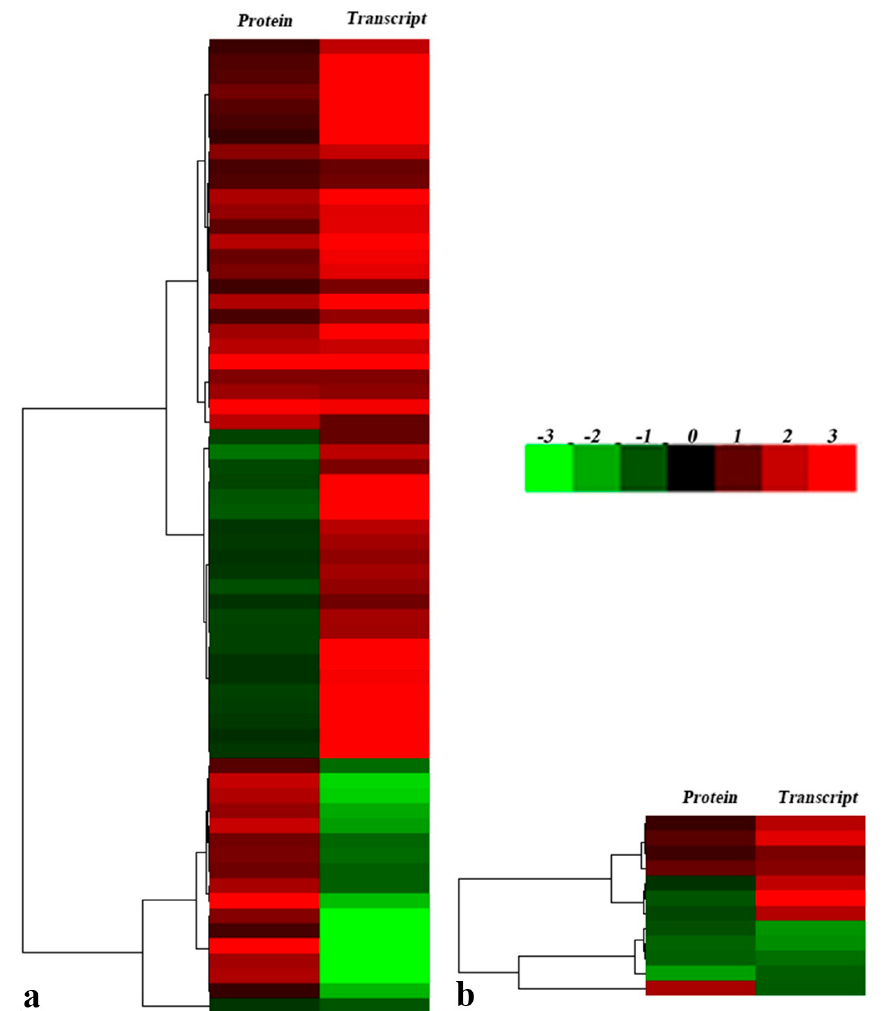
Figure 7. Association clustering analysis of differentially expressed proteins and its corresponding transcripts. Protein ( left ) represents the expression levels of differentially expressed proteins, Transcript ( right ) represents the expression profile of the corresponding genes encoding differentially expressed proteins. ( a ) leaf of ramie; ( b ) root of ramie. Upregulated proteins are in red; downregulated proteins are in green (for interpretation of the color references in the figure legend).